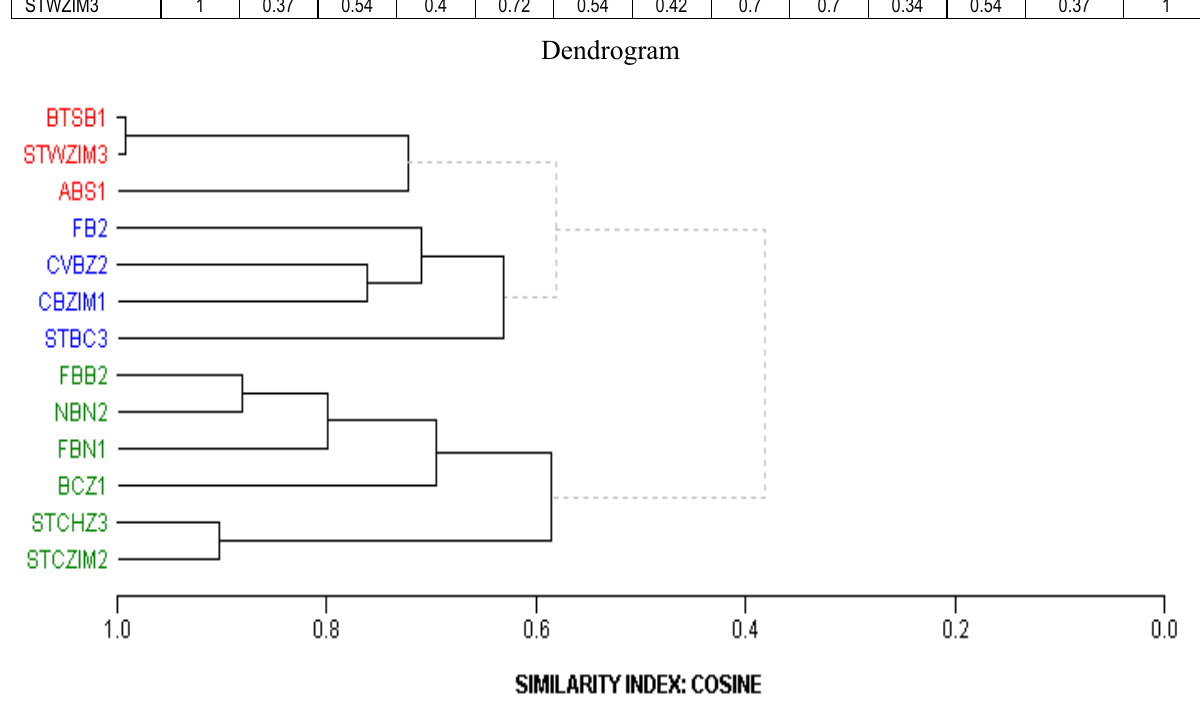
Fig. 1. Internet banking awareness similarity